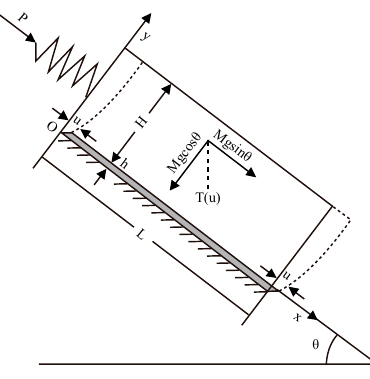
Figure 2. Locked section sliding mechanical (LSSM) model.